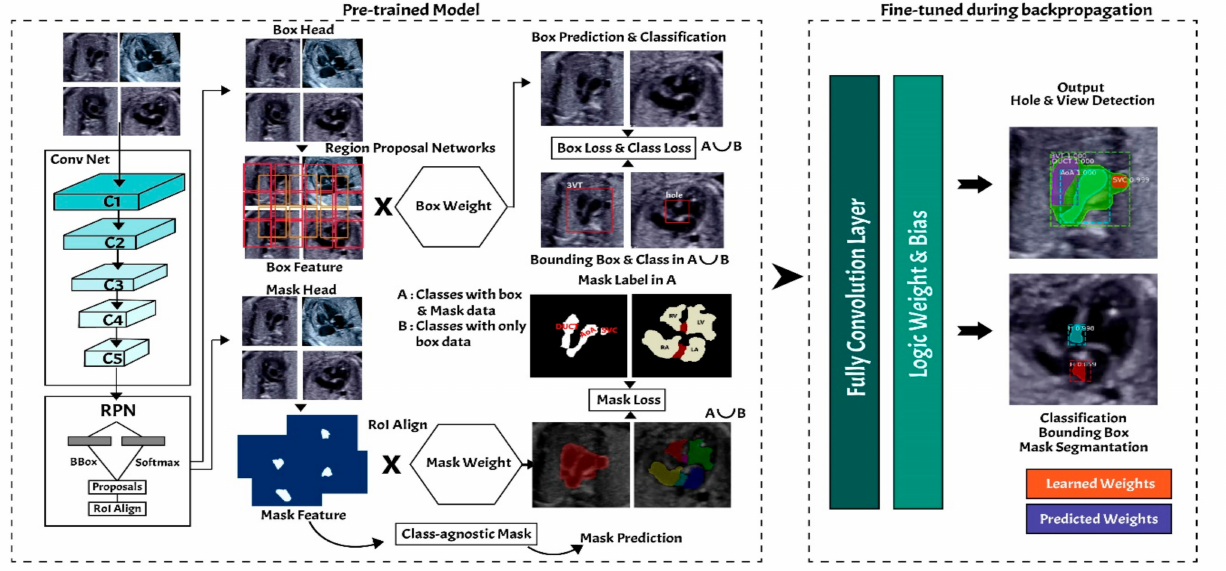
Figure 1. The proposes workflow of fetal heart standard view segmentation for heart defect detection with instance segmentation